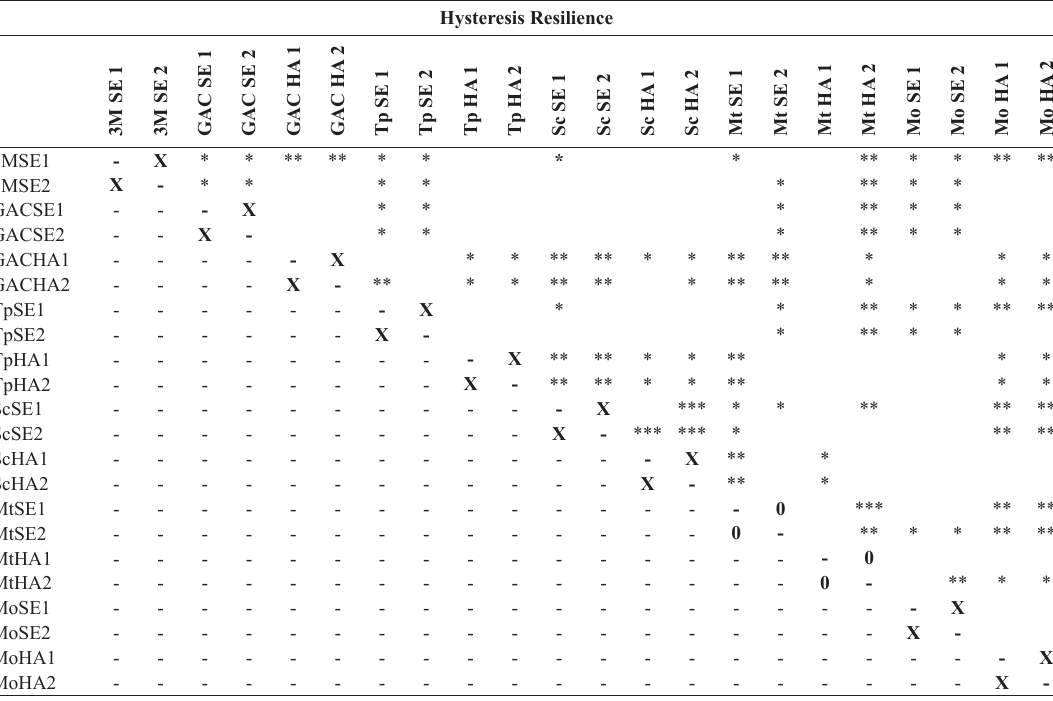
Table 8. Hysteresis resilience comparison among different groups and commercial lots by Tukey test (p=0.05). Hysteresis